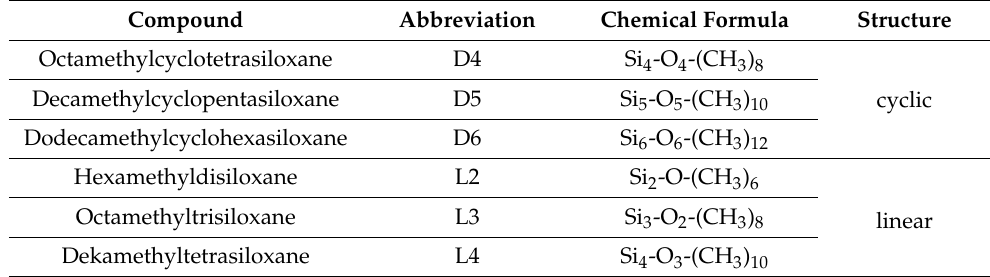
Table 1. Main VMSs identified in biogas from sewage sludge and landfills. Compound Abbreviation Chemical Formula